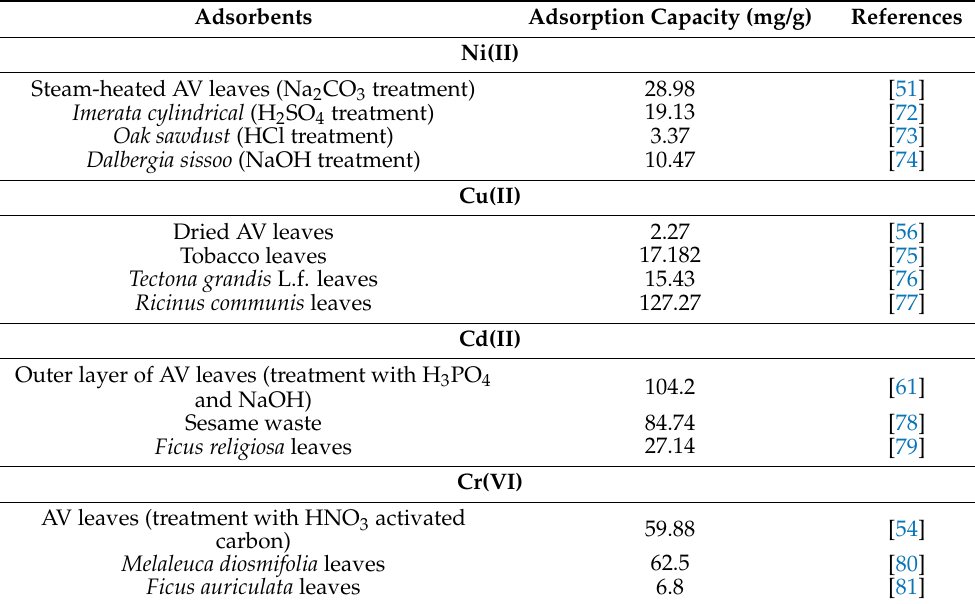
Table 3. Maximum adsorption capacity of Aloe vera based biosorbents compared to other natural products for Ni(II), Cu(II), Cd(II) and Cr(VI).